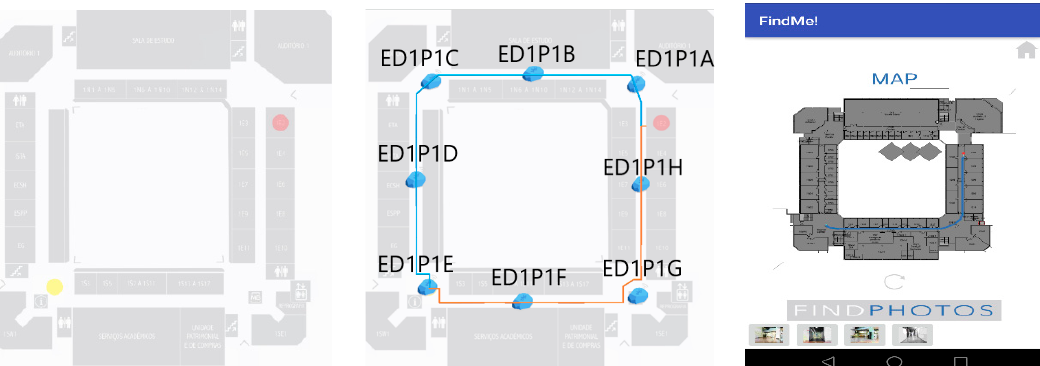
Figure 15. Test 1—yellow point marks the start, the red point marks the destination ( Left ); path taking into account two path options with beacon signal information ( Center ); an example of a screen App with map path and the possibility of displaying photos ( Right ).